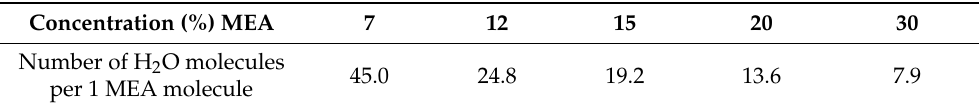
Figure 8. Differential spectrum of MEA (30%) registered at 90 °C. Table 4. The ratio of % concentration of MEA in water and the number of water molecules per 1 molecule of MEA in these